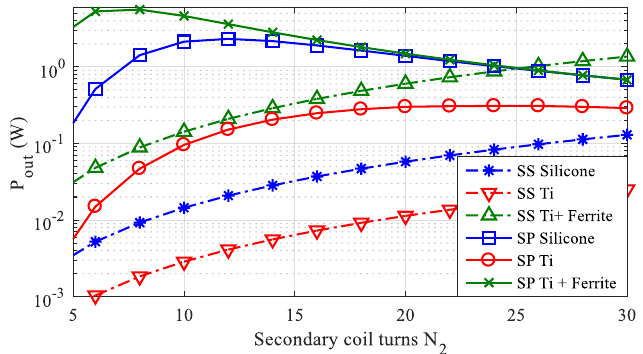
Figure 13. Output power P out vs. N 2 for SS and SP compensation topologies.